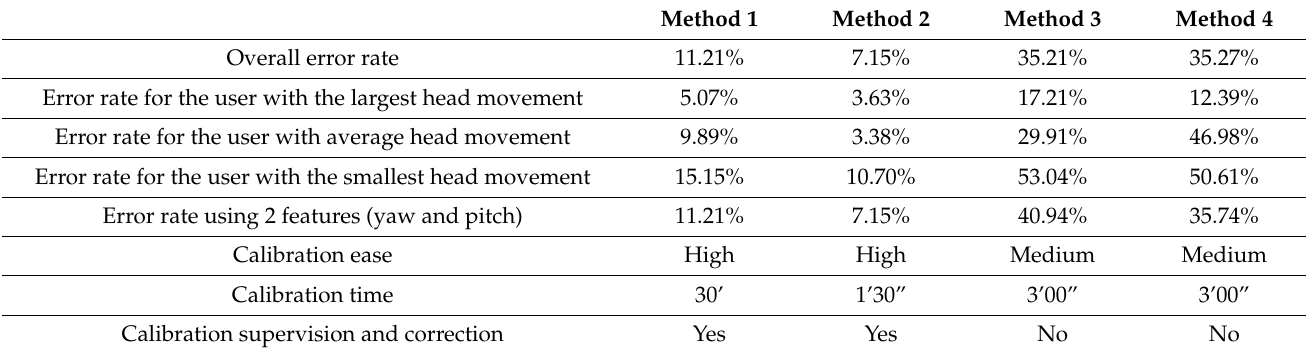
Table 7. Comparative summary of the four Kinect-based